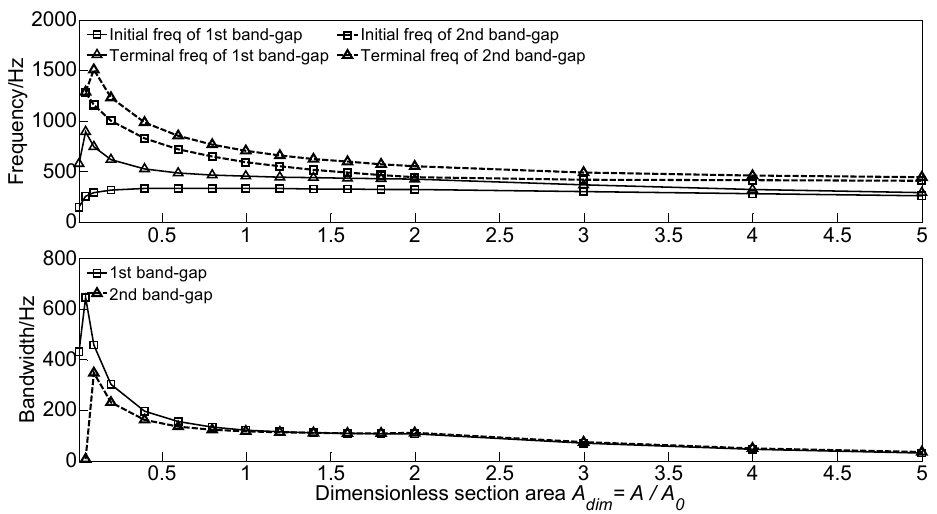
Figure 12. Band gaps maps as functions of dimensionless section area A dim.